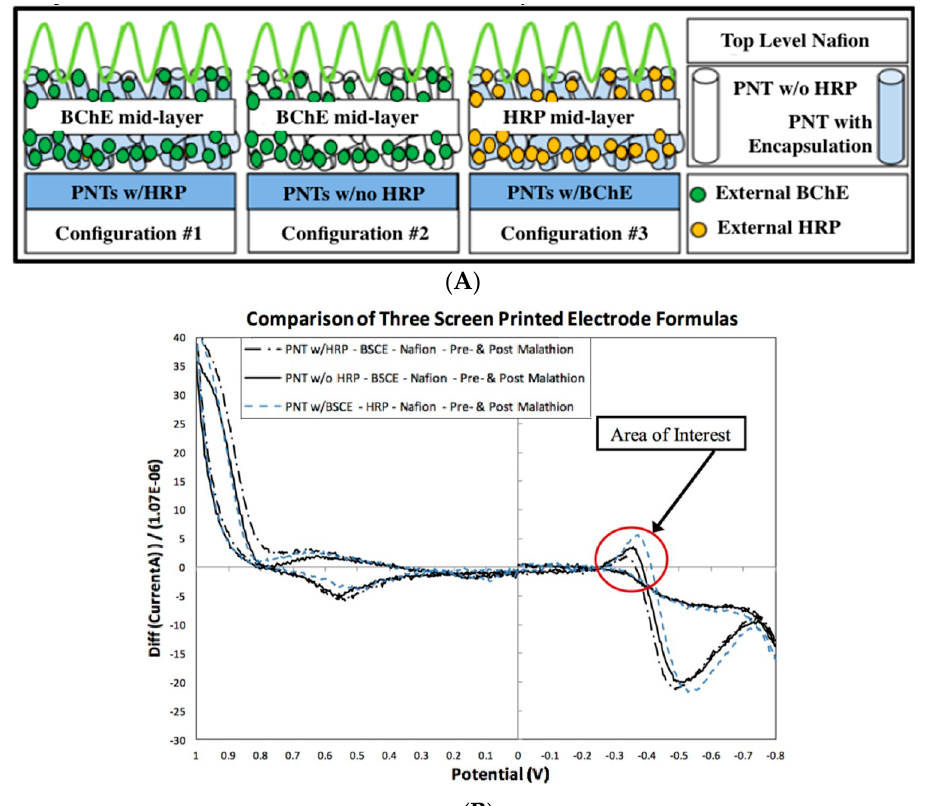
Figure 2. ( A ) Three different sensor configurations; ( B ) Cyclic voltammogram of three different configurations for malathion inhibition. Table 1. Average percentage of malathion inhibition of three different configurations.